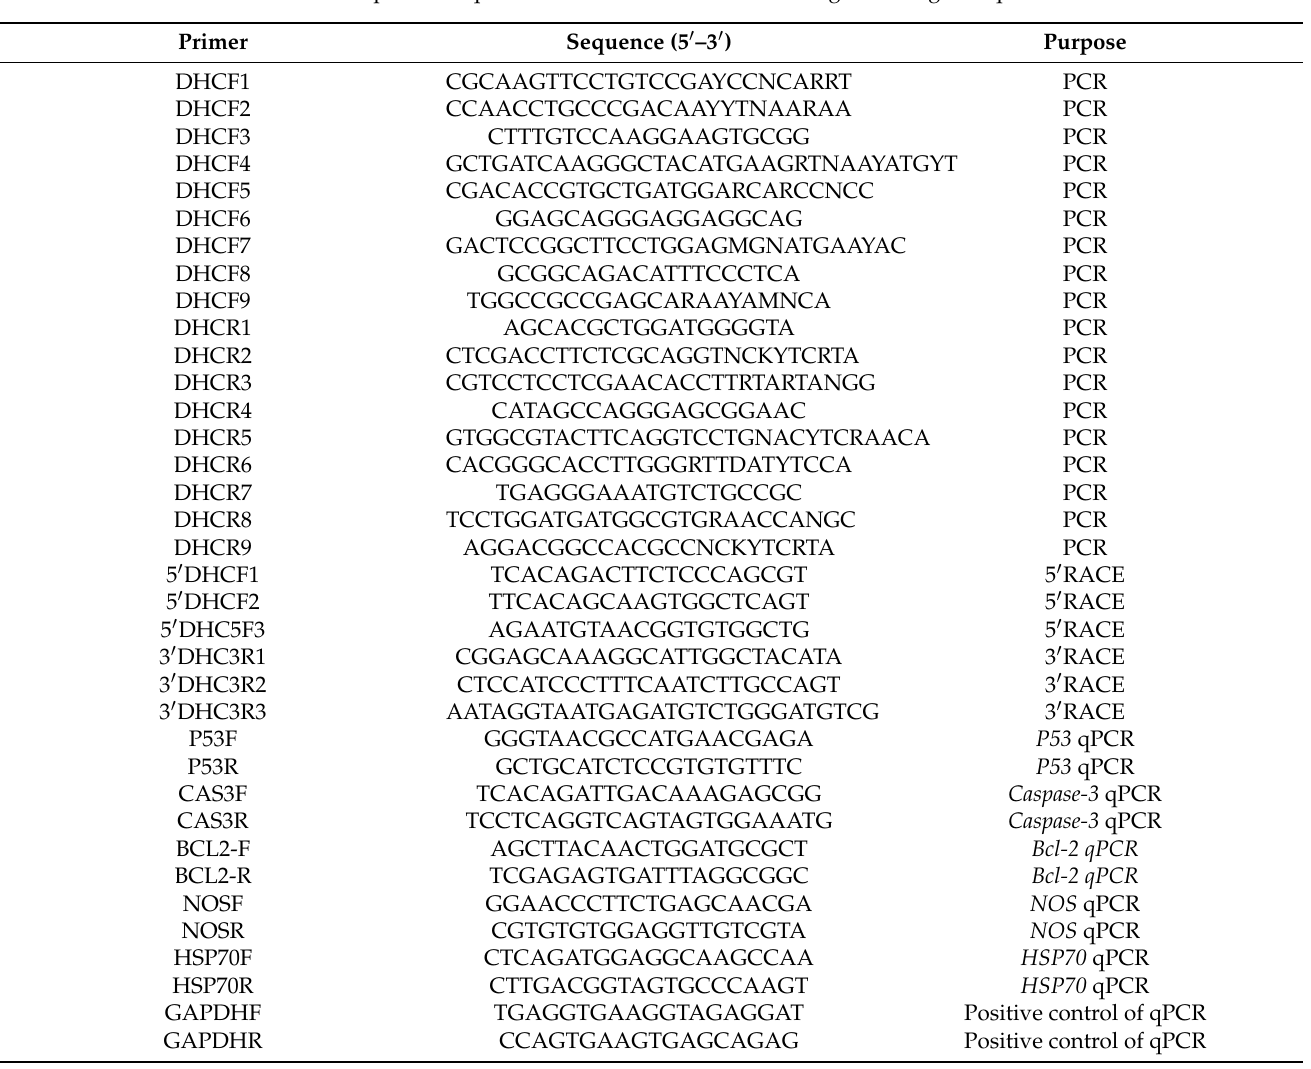
Table 1. The primer sequence used in Pt-dhc cDNA full-length cloning and qPCR. Primer Sequence (5 (cid:48) –3 (cid:48)